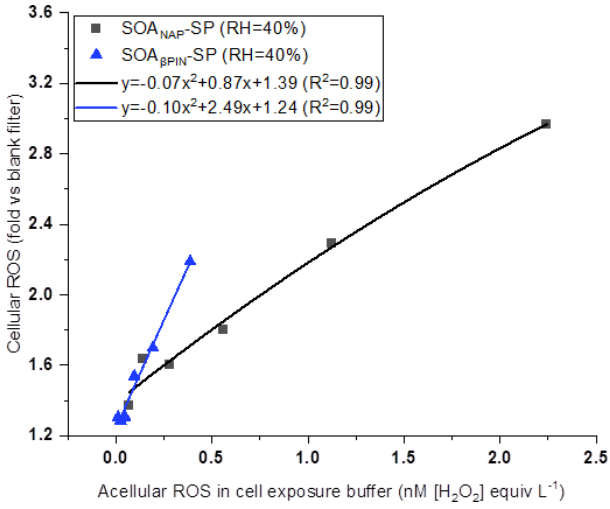
Figure 10. A positive correlation between acellular ROS con- centration in cell exposure experiments and fold change of cellu- lar ROS production. Under a similar acellular ROS concentration, SOA β PIN -SP exhibited a high ability of cellular ROS production compared to SOA NAP -SP as evident from the higher slope of the polynomial